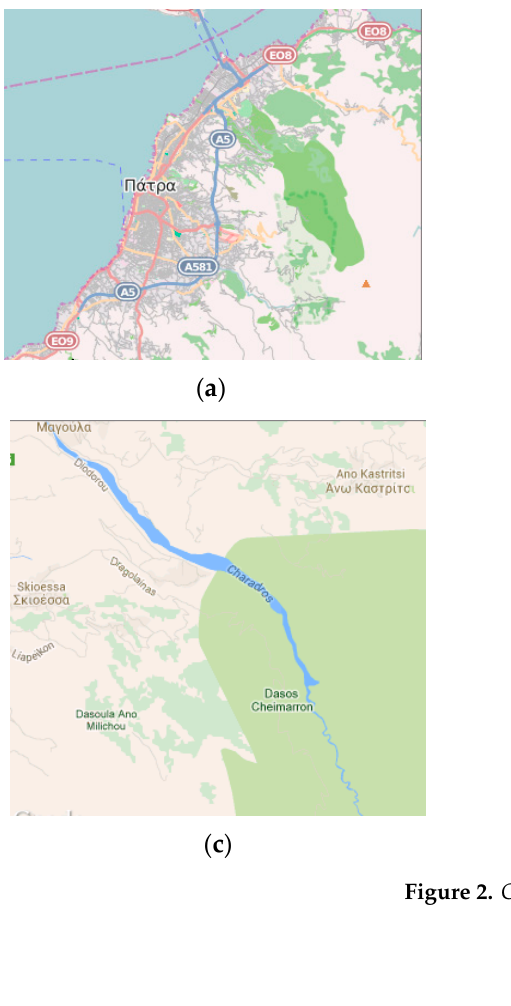
Figure 2. Generalization issues: ( a ) excessive detail in relation to the scale level in the road network; ( b ) very small buildings are portrayed; ( c ) different degree of generalization in the river network and the land use; ( d ) overlay problems between layers e.g. road network, urban area, park and lack of detail in layers e.g. the road network; ( e ) overlay problems between layers e.g. road network, land and sea; ( f ) problems in establishing information hierarchy. Online map services should reconsider the portrayal of terrain, land use and sea area. The terrain is portrayed with shading in Google (upon user selection “Terrain” or at smaller scales) and HERE maps. Spot heights are depicted in OSM and no terrain information appears in Wikimapia. As a result, in Google and HERE, the user is generally informed about the terrain as needed. Especially for OSM, partial terrain portrayal (only with spot heights) is acceptable for maps of urban areas at large scale but the addition of shading would be most welcome for rural area maps or at smaller scale maps. Land use is portrayed with more categories in OSM, whereas Google, HERE and Wikimapia just indicate green areas. The problem is evident in Google maps where empty areas appear due to the